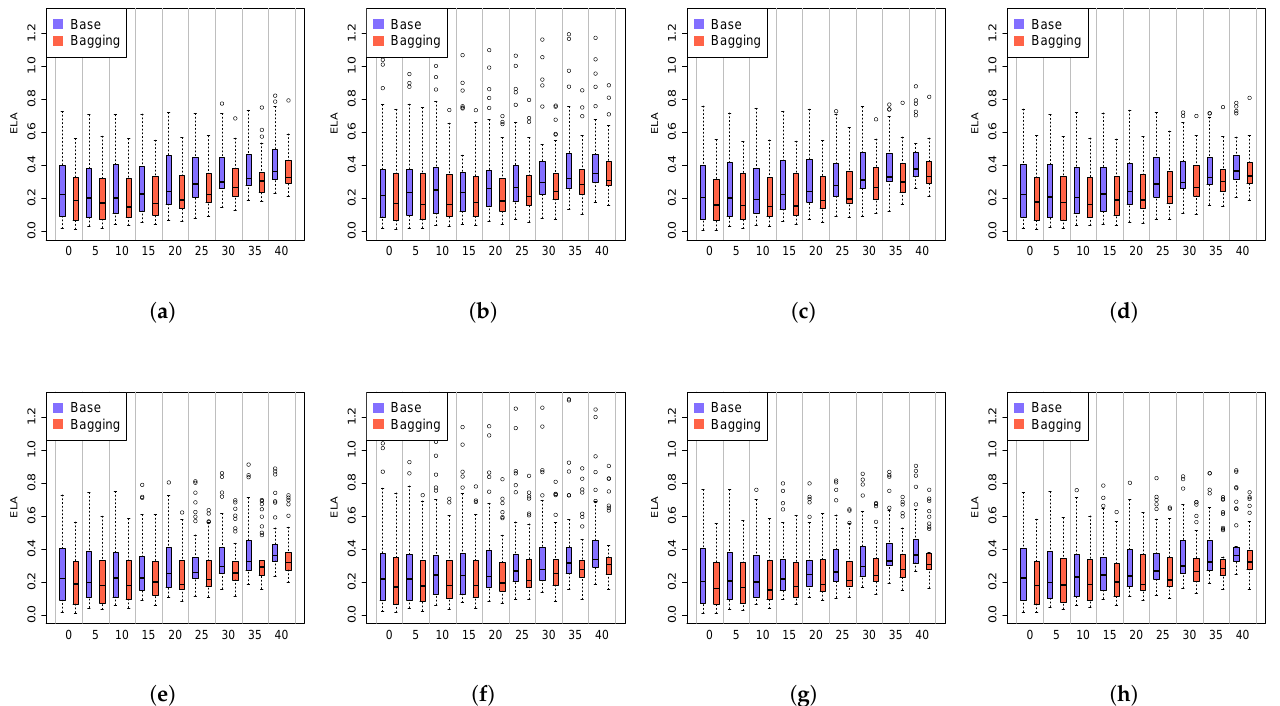
Figure 2. Distributions of robustness results ( ELA ) for each classification algorithm ( C4.5 , RIPPER , PART , and C5.0 ) at each noise level and borderline noise model ( neighborwise and non-linearwise